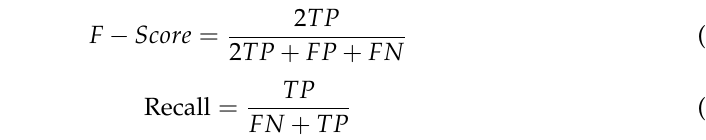
Table 1. Precision of DLBTDC-MRI method with existing system.